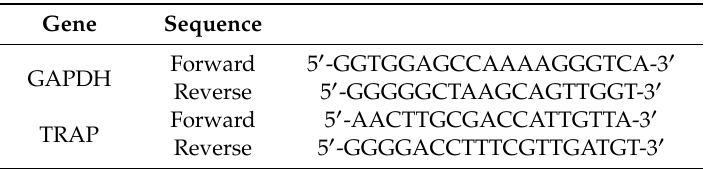
Table 1. Primers used for real-time RT-PCR.